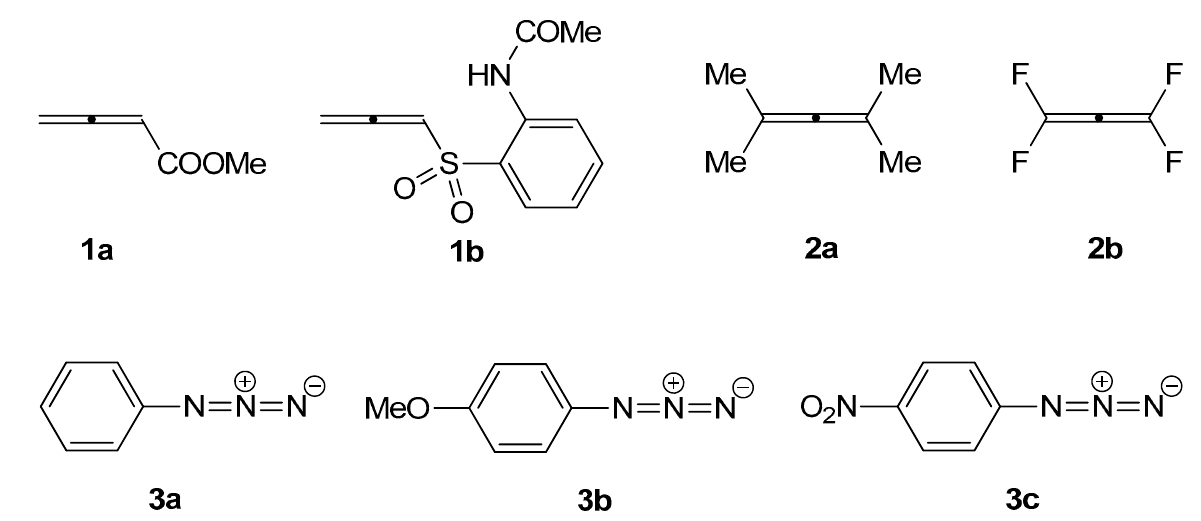
Figure 1. Mono- and tetra-substituted allenes to be submitted to cycloaddition with arylazides 3 .